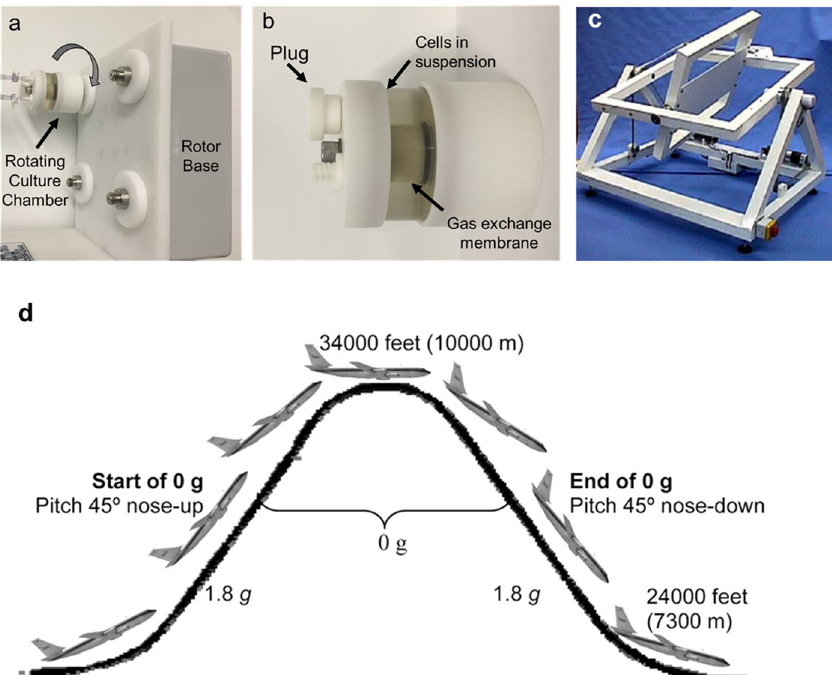
Fig. 1 Representative examples of experimental methods used to simulate microgravity. Panels a , b show digital images of a rotating wall vessel (RWV) bioreactor. Here vascular cells are grown in culture chambers which are then rotated concentrically around a single axis. Panel c shows a RPM with two independently driven perpendicular frames 83 . Panel d shows the parabolic fl ight trajectory 84 used to create short- duration microgravity